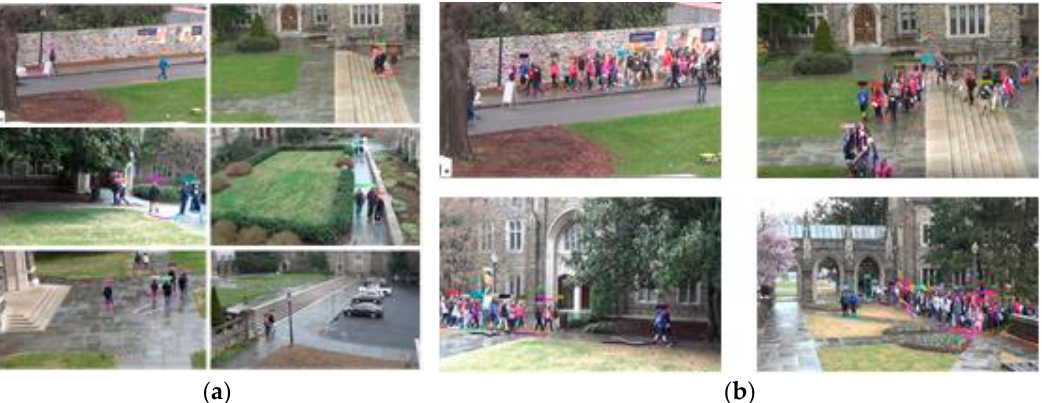
Figure 10. Some fragments of single-camera tracking. The results from Cam1~Cam8 are showed above. Subfigure ( a ) shows the trajectories of the test-easy dataset and subfigure ( b ) displays the obtained trajectories from the test-hard